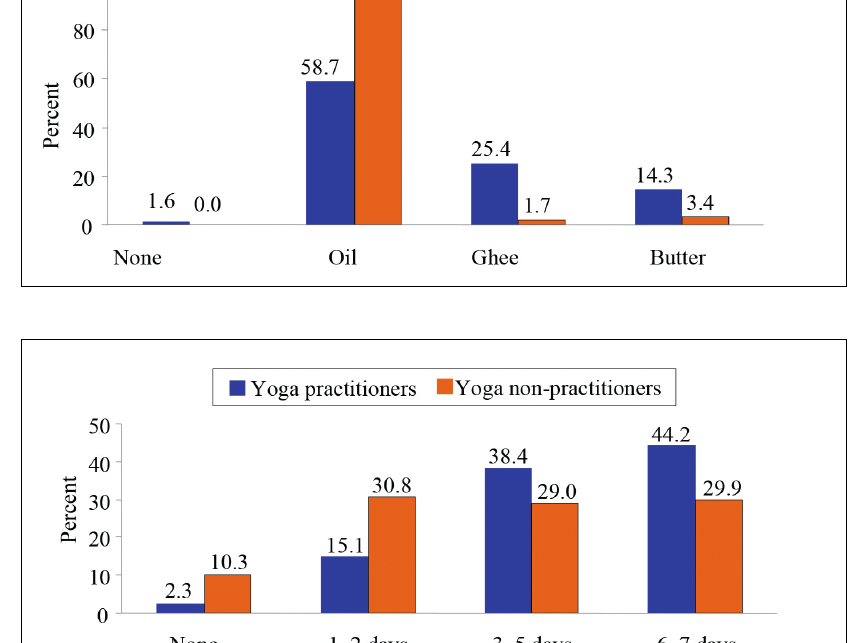
Figure 4. Pattern of fat intake in women yoga practitioners and non- practitioners according to type of